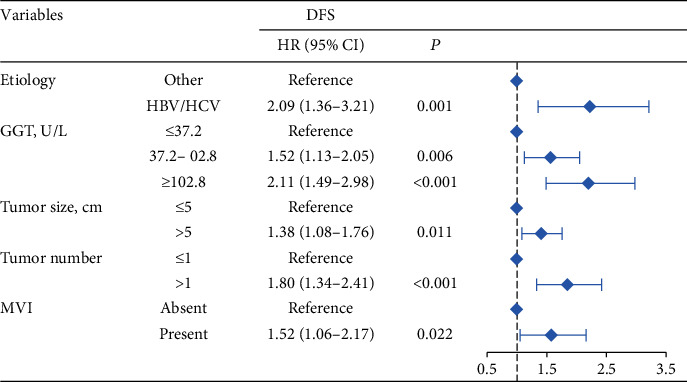
Multivariate analysis and forest plot of the hazard ratio of risk factors for disease-free survival. DFS: disease-free survival; HR: hazard ratio; CI: confidence interval; HBV: hepatitis B virus; HCV: hepatitis C virus; GGT: gamma-glutamyltransferase; MVI: microvascular invasion.